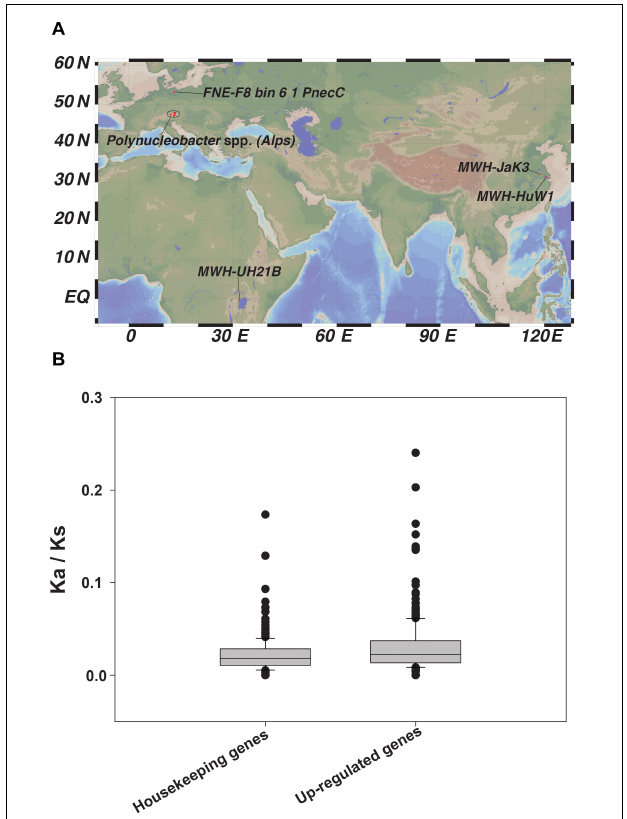
FIGURE 6 | (A) Geographical distribution of the 20 Polynucleobacter spp. used in our study and (B) Ratio of non-synonymous ( K a) to synonymous ( K s) nucleotide substitution represented as box-plot for selected housekeeping genes and other selected up-regulated genes chosen from our -omics